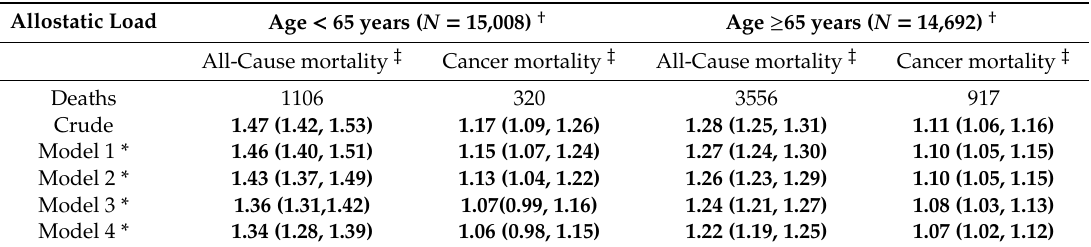
Table 5. Multivariable Adjusted Cox Proportional Hazards Models * for the Association †‡ of Allostatic Load Score with All-Cause and Cancer-Specific Mortality in REGARDS Stratified by Age Group ( N = 29,700).